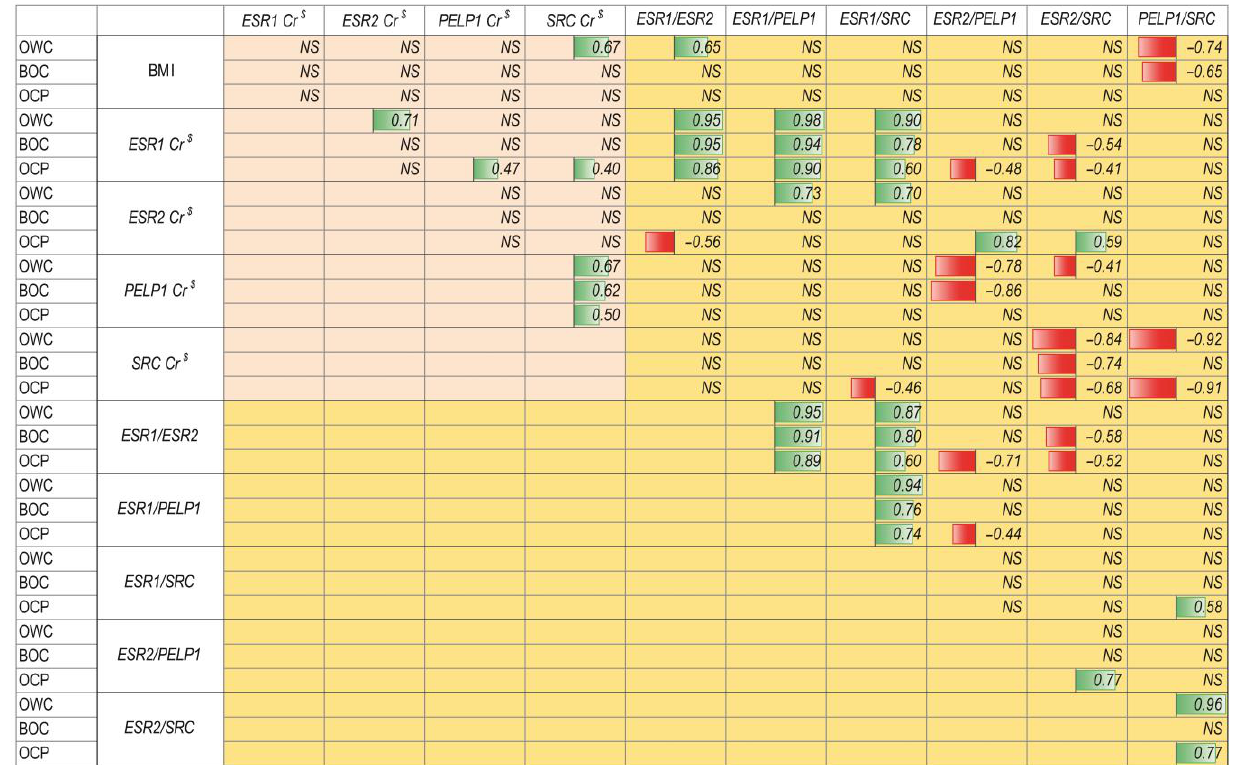
Figure 3. Correlation coefficient plot of ovarian tissue samples lack of any changes patients (OWC) females with benign noncancerous changes in the ovary (BOC) and ovarian cancer patients. Designation: NS — not significant; numbers — Spearman rank correlation coefficients; green bars — proportional correlation; red bars — reverse proportional correlation. Green background — clinical data correlations; pink background — gene expression correlations; yellow background — gene expression quotient ratio correlations. Cr $ concentration ratios data normalized using min-max normalization.